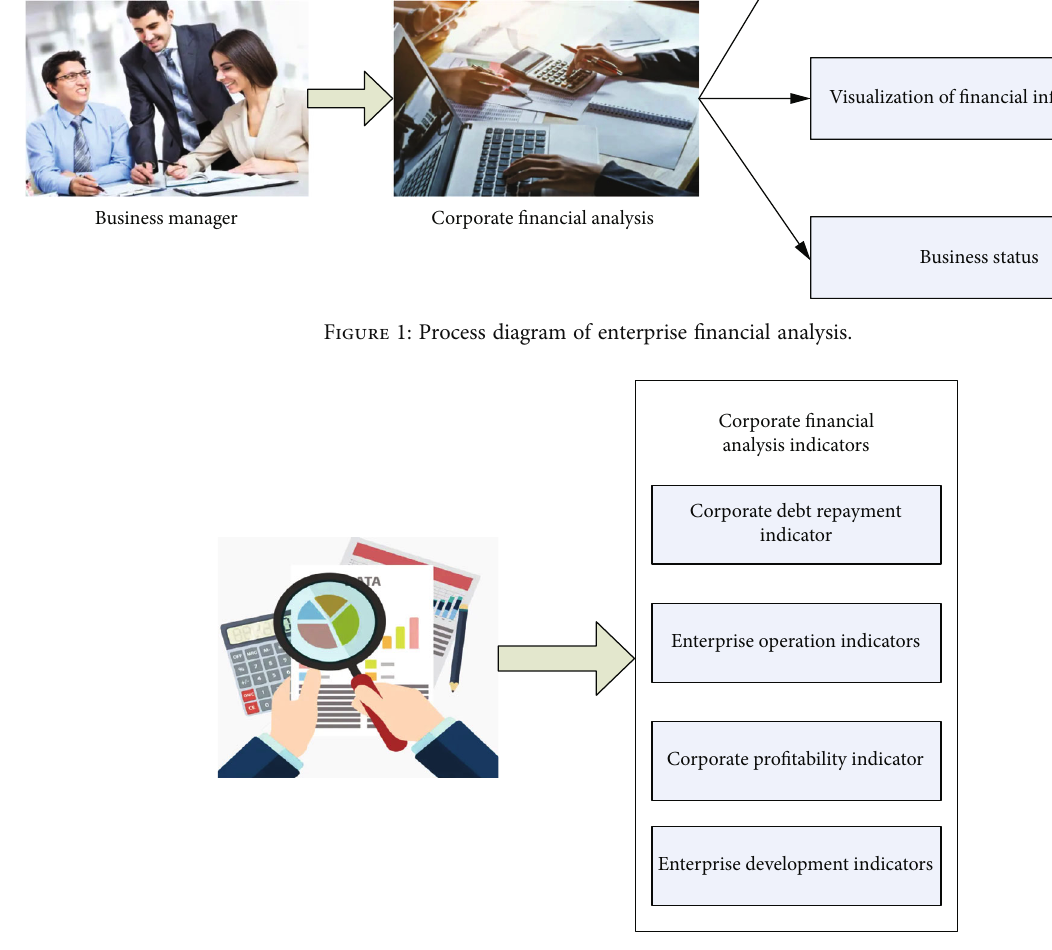
Figure 2: Structure model diagram of corporate fi nancial analysis